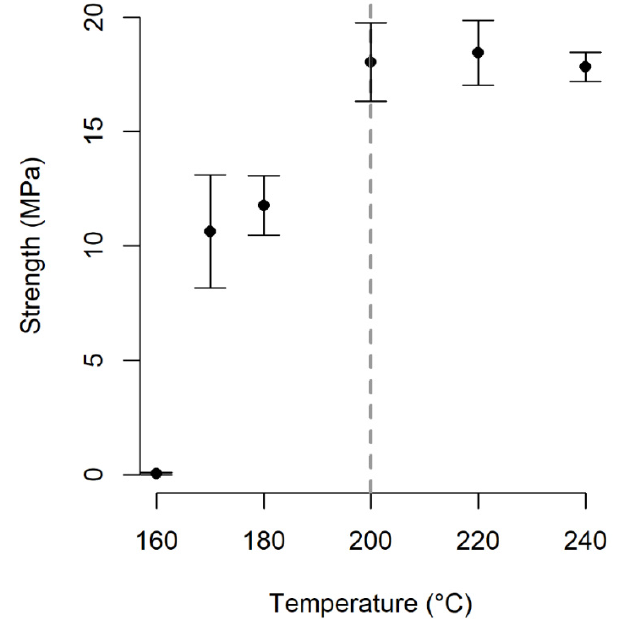
Figure 7. Variation of tensile strength versus heating temperature at constant holding time and pressure for PA12-EMG. EMG stands for Elium ® -GMA-Glass composite.